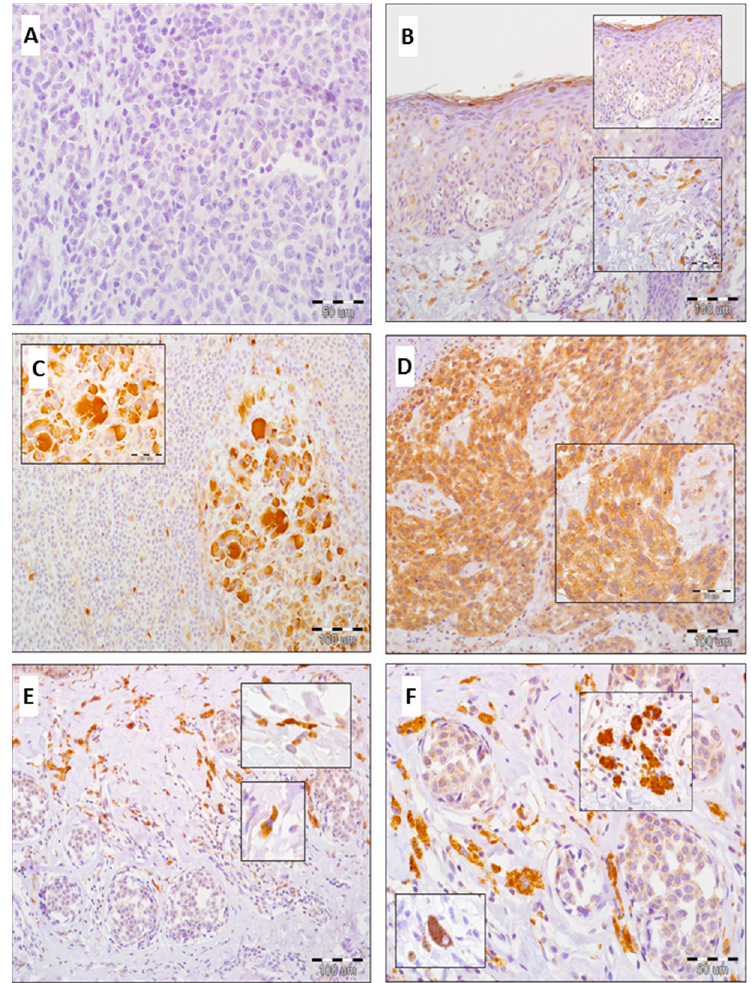
Figure 3. GOLPH3 expression in skin melanoma patients. Lack of GOLPH3 reactivity in invasive melanoma (( A ) 400×, hematoxylin); In situ component of melanoma with scanty expression of GOLPH3 in neoplastic cells and with moderate reaction in macrophages and fibroblasts (( B ) 100×, 200×, 400×, hematoxylin); High cytoplasmic GOLPH3 expression in neoplastic melanocytes and lack of GOLPH3 reactivity in TILs, higher magnification: bizarre neoplastic melanocytes with typical malignant cytomorphology (hyperchromasia and aberrant nuclear shape, high nuclear/cytoplasmic ratio, prominent nucleoli) (( C ) 100×, 600×, hematoxylin); Diffuse, strong GOLPH3 reactivity in melanoma cells, higher magnification: GOLPH3-positive melanoma cells with atypical mitotic